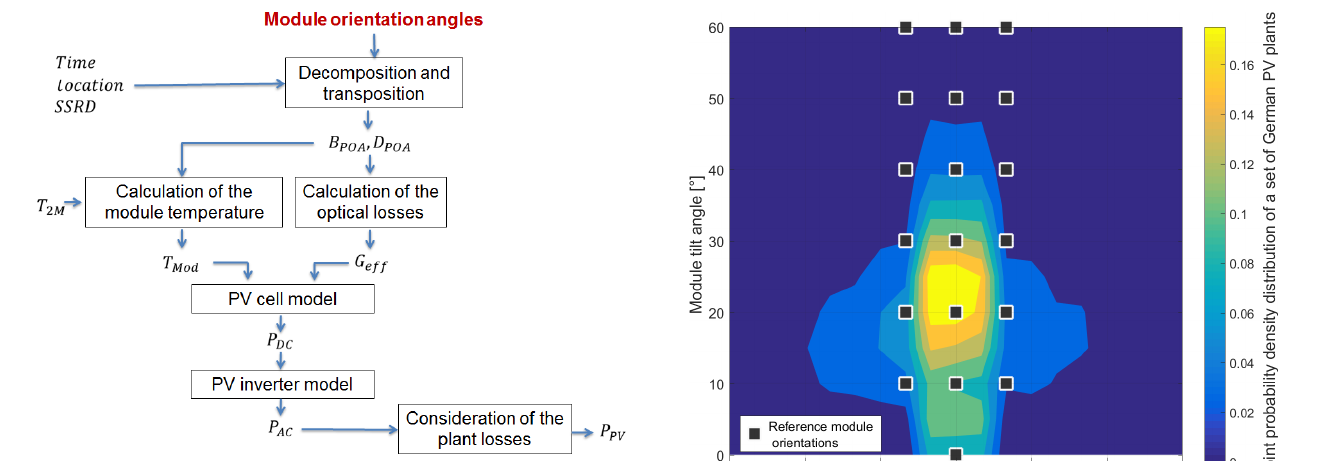
Figure 1. Flow chart of the single PV plant model.